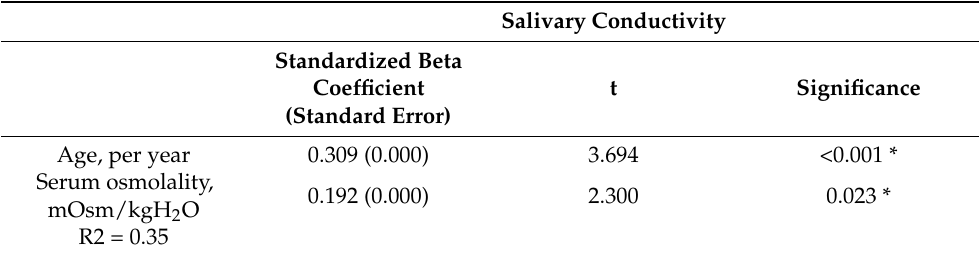
Table 3. The relationship between salivary conductivity and clinical parameters by multiple linear regression.